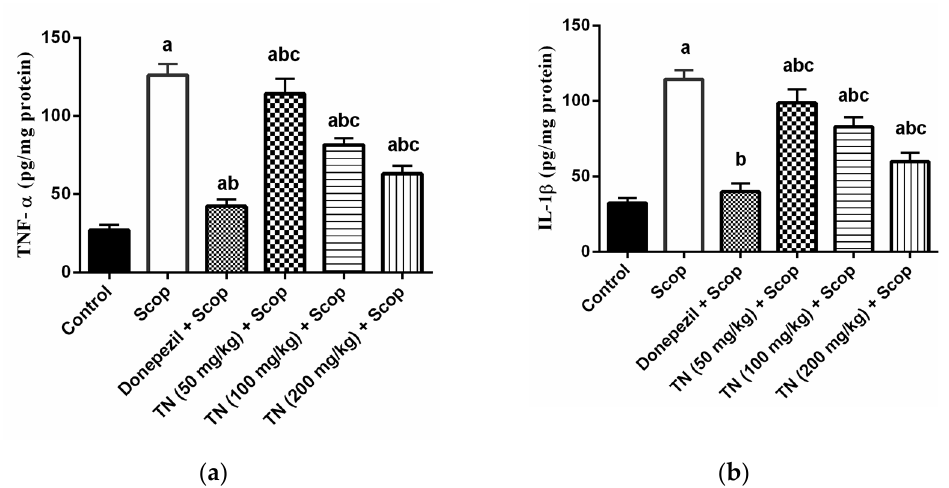
Figure 5. Effect of different doses of tiger nut on Scop-induced neuroinflammation. ( a ) TNF- α and ( b ) IL-1 β . Values are expressed as the mean ± SD ( n = 6). Values are statistically significant at p < 0.05 versus the control group, p < 0.05 versus the Scop-treated group and p < 0.05 versus the donepezil-treated group.